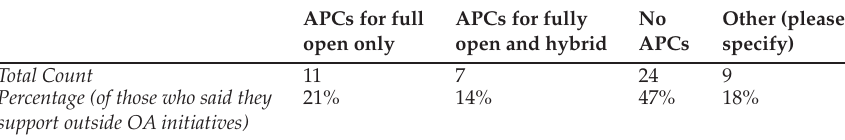
Table 1: Does your library provide financial support for APCs only for fully open publishers, or for hybrid publishers as